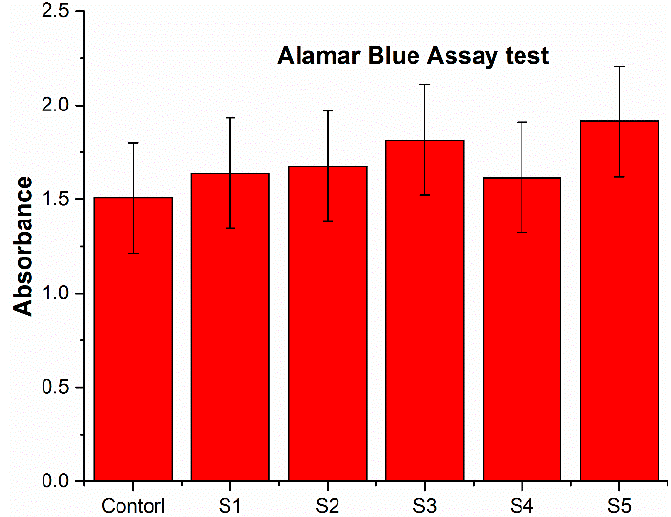
Figure 7. Cytotoxicity assessment of all the samples.